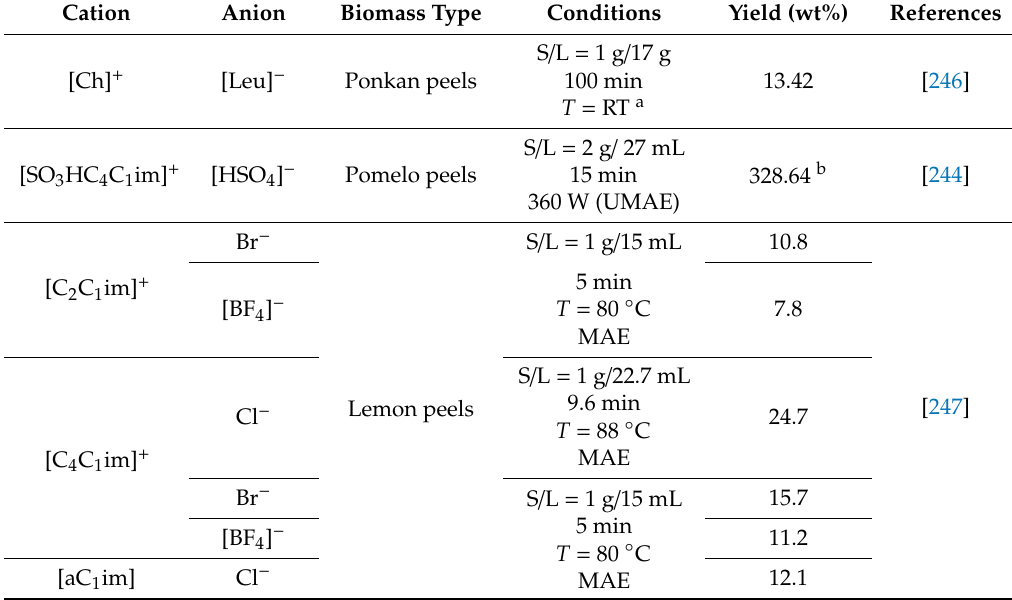
Table 8. ILs reported to extract pectin, pectin yield and experimental conditions applied.